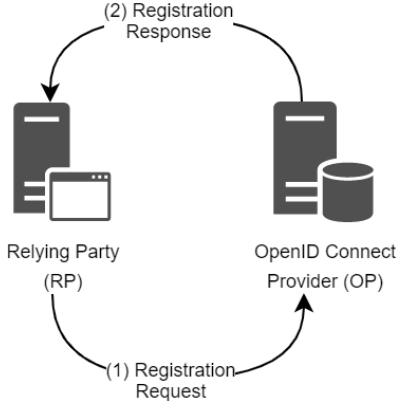
Figure 2. OIDC Dynamic Client